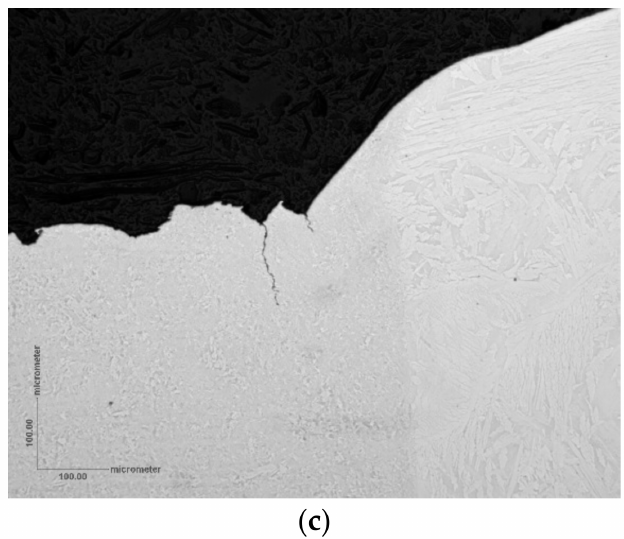
Figure 2. Examples of crack precursors; ( a ) cracks emerging from corrosion pit in 12Cr blade steel in simulated steam turbine condensate. Reprinted with permission from [4] Copyright @ National Physical Laboratory; ( b ) stress corrosion cracks formed from dealloyed layer in DSS in evaporated seawater conditions at elevated temperature. Reprinted with permission from [5] Copyright 2016 Crown Copyright; ( c ) stress corrosion crack in welded 13Cr MSS in simulated oilfield brine in H 2 S/CO 2 at elevated temperature [6]. Figure 2c is copyright © Institute of Materials, Minerals and Mining, reprinted by permission of Informa UK Limited, trading as Taylor & Francis Group, on behalf of Institute of Materials, Minerals and